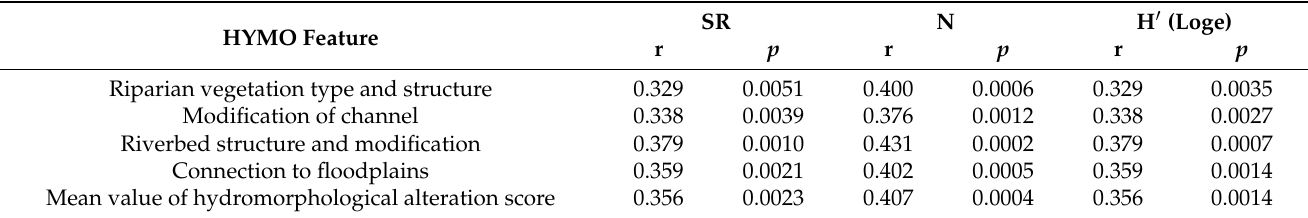
Table 2. Values of Spearman correlation coefficient (r) between different hydromorphological (HYMO) features of the sampling sites (riparian vegetation type and structure, degree of channelization, riverbed structure and connection to floodplains, mean value of hydromorphological degradation score) and water mite assemblage characteristics [abundance (N, number of animals/m 2 ), species rich- ness (SR), Shannon diversity index [H (cid:48) (loge)]. All the above correlations are statistically significant (adjusted p -value < 0.03).